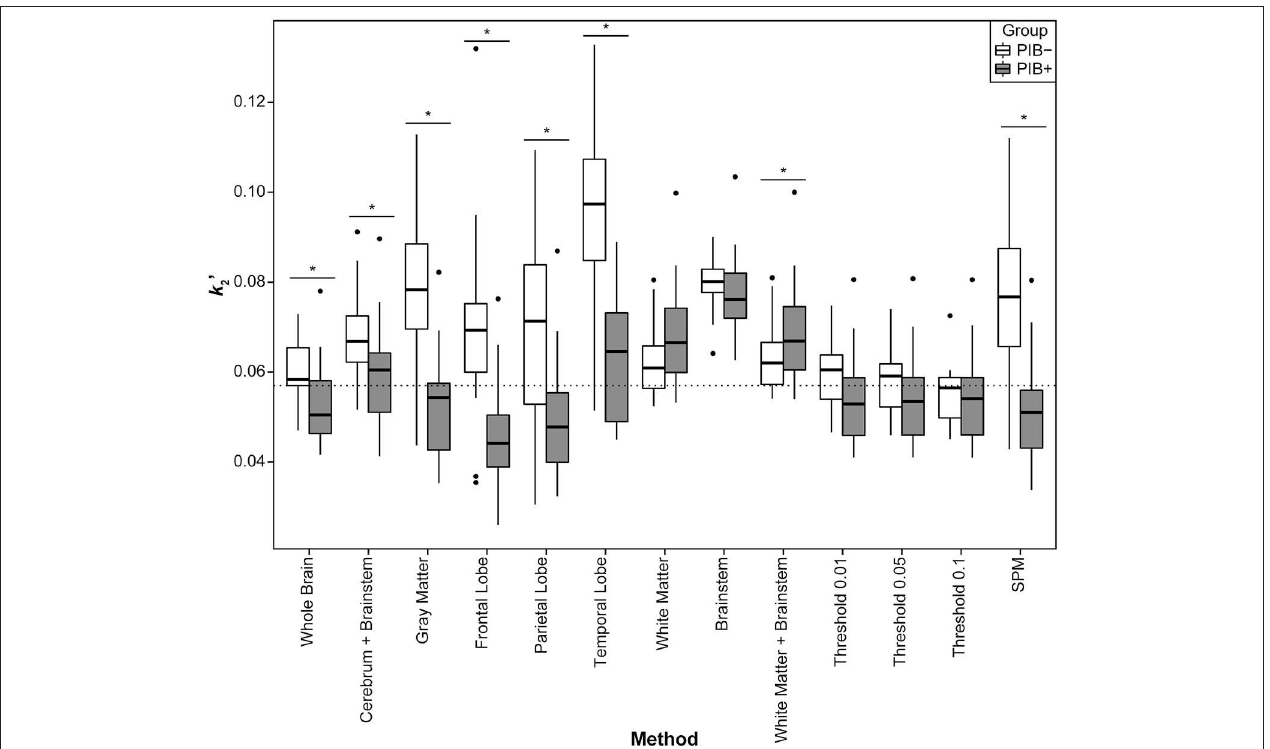
FIGURE 3 | Distribution of individual subject’s k ′ 2 values per group for all methods. The boxes show the interquartile range of distribution, the solid line shows the median k ′ 2 value for the group, the whiskers expand up to 1.5 times the interquartile range, and the further points are the outlier subjects. In white, the values from the PIB– subjects, and in gray, from the PIB + patients. The dashed line corresponds to the median value from all subjects combined for the Whole Brain method. The stars show which methods presented a significant difference between groups resulting from the t